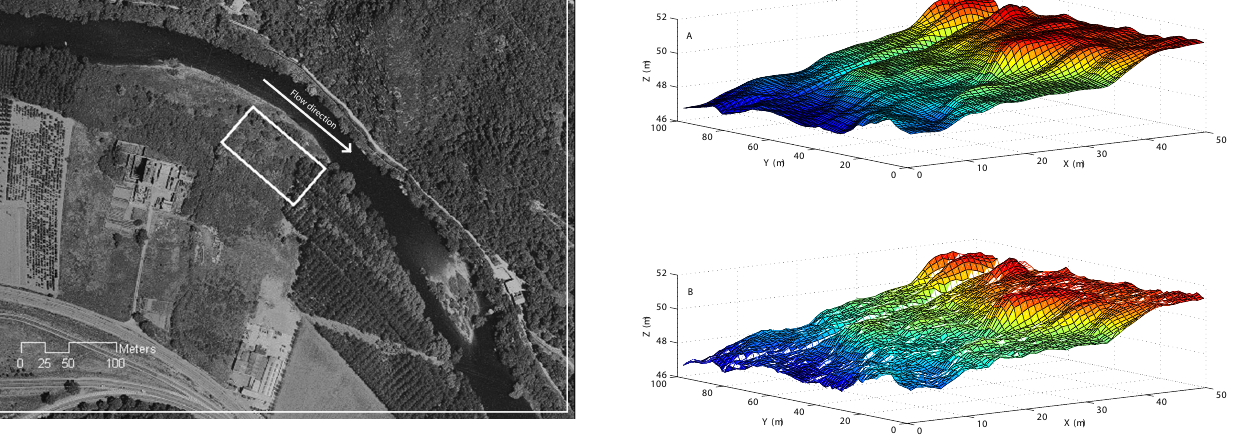
Fig. 3. Generation of DEMs with additional topographic informa- tion. (A) Reference DEM, (DEM ref ) ; (B) DEM with additional to- pographic content of ± 25cm (DEM ± 25cm ) . The origin of the plot corresponds to the corner of the detailed rectangle in Fig. 1, which is downstream and closer to the river